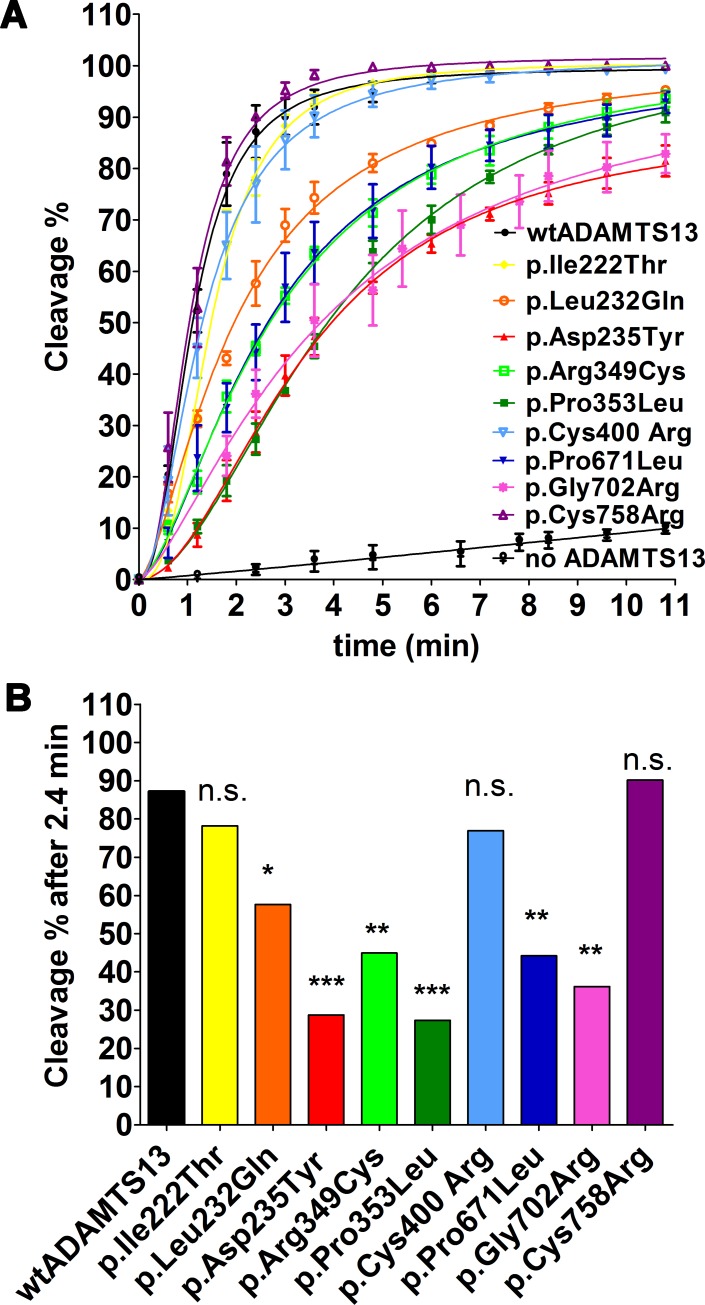
Proteolysis of VWF strings at the surface of HUVEC by recombinant ADAMTS13 variants under flow.(A) HUVEC were perfused at 5 dyne/cm2 shear stress with 1 mM histamine and 100 μl of GPIbα-beads in HBRS buffer. Capturing of an automated time-lapse multi-picture series of 12 images every 36 sec for 12 min was started before addition of 100 ng/ml recombinant ADAMTS13 variants. Analysis was performed by merging the 12 images of each time point to one big image, a 100 μm scale bar was used to calibrate the scale in ImageJ to mm and the length of 100 strings was measured. The overall string length at 0 min was defined as 0% cleavage and % cleavage for each frame was determined by the decrease of the overall string length in %. Mean values ± SEM of 3–4 experiments per variant are shown. Exemplary analyses are shown in the S2 Fig. (B) % cleavage of VWF strings by ADAMTS13 variants within 2.4 min. The values were extracted from the experiments shown in panel (A) and are presented as bar graphs. Mean values ± SEM of 3–4 experiments. Unpaired Student’s t test was performed using GraphPad Prism version 5.02 for Windows, GraphPad Software (La Jolla California USA, www.graphpad.com). ns p > 0.05, *p ≤ 0.05, **p ≤ 0.01, ***p ≤ 0.001.